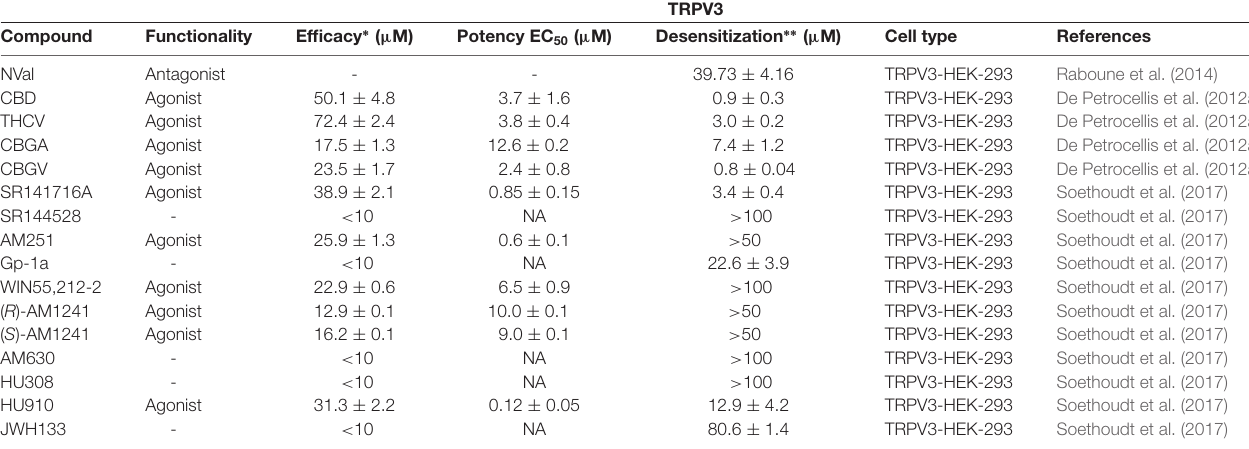
TABLE 3 | Functionality of phytogenic, endogenous, and synthetic cannabinoid ligands at TRPV3.